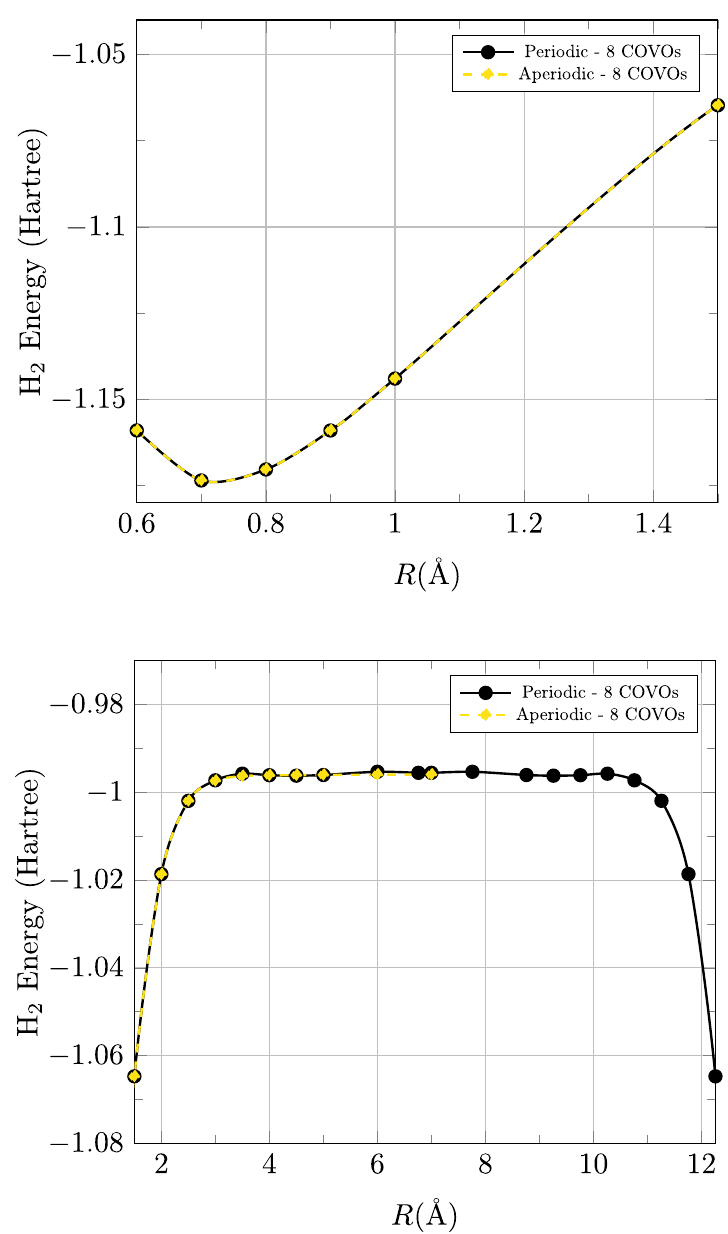
Fig. 3 Total energies as a function of distance from aperiodic and periodic plane-wave FCI calculations for the H 2 molecule with 8 correlation optimized virtual orbitals. The top plot shows energy from R R 1.5 Å, and the bottom plot shows energy from R =